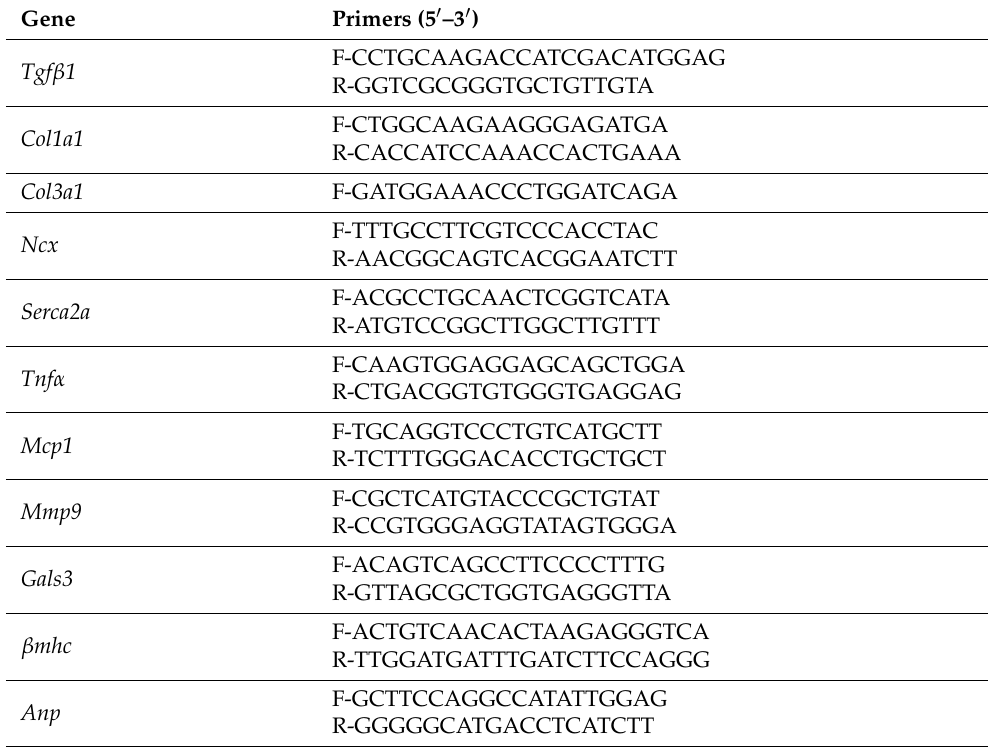
Table 4. Primer list for genes involved in cardiac remodeling.